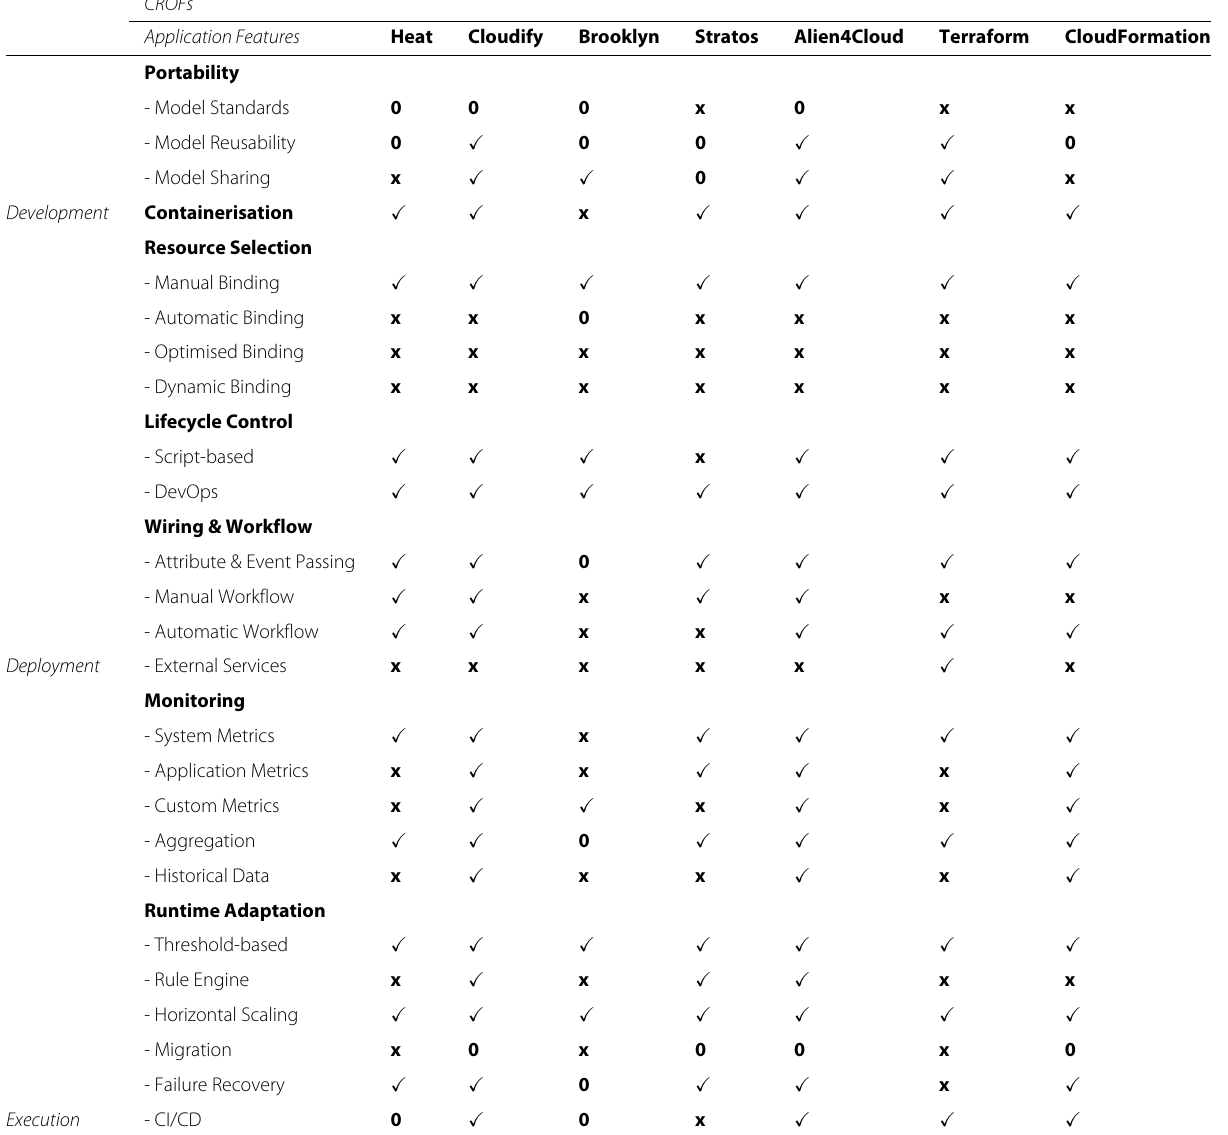
Table 3 Application-based comparison of production/commercial